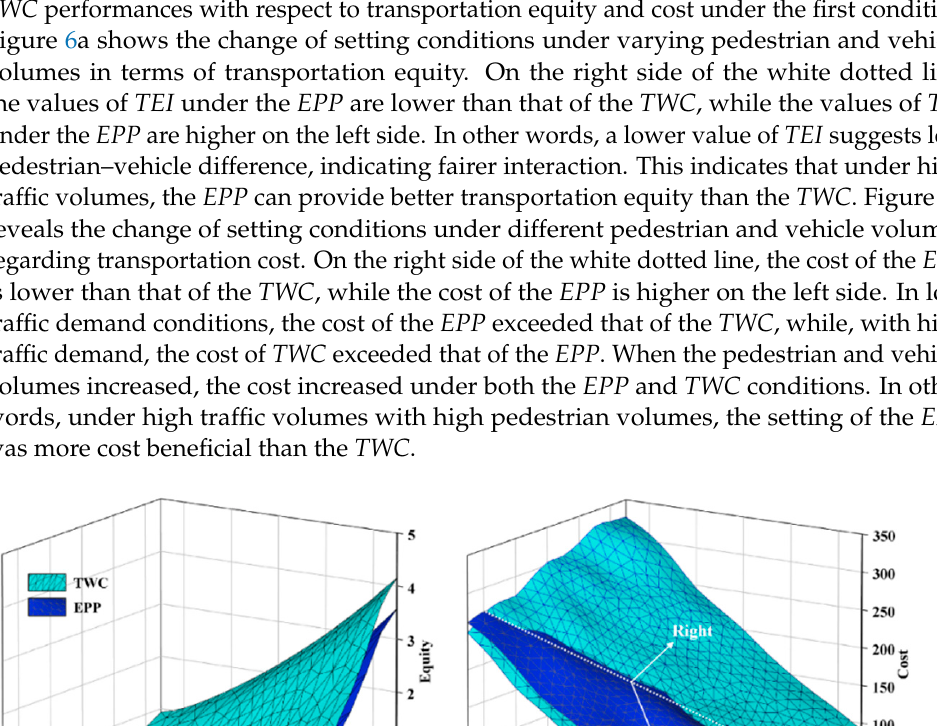
Figure 7. Phase setting and traffic demand under different vehicle yielding rates in the first condi- tion: ( a ) vehicle yielding rate, 20%; ( b ) vehicle yielding rate, 40%; ( c ) vehicle yielding rate, 60%; ( d ) vehicle yielding rate, 80%.